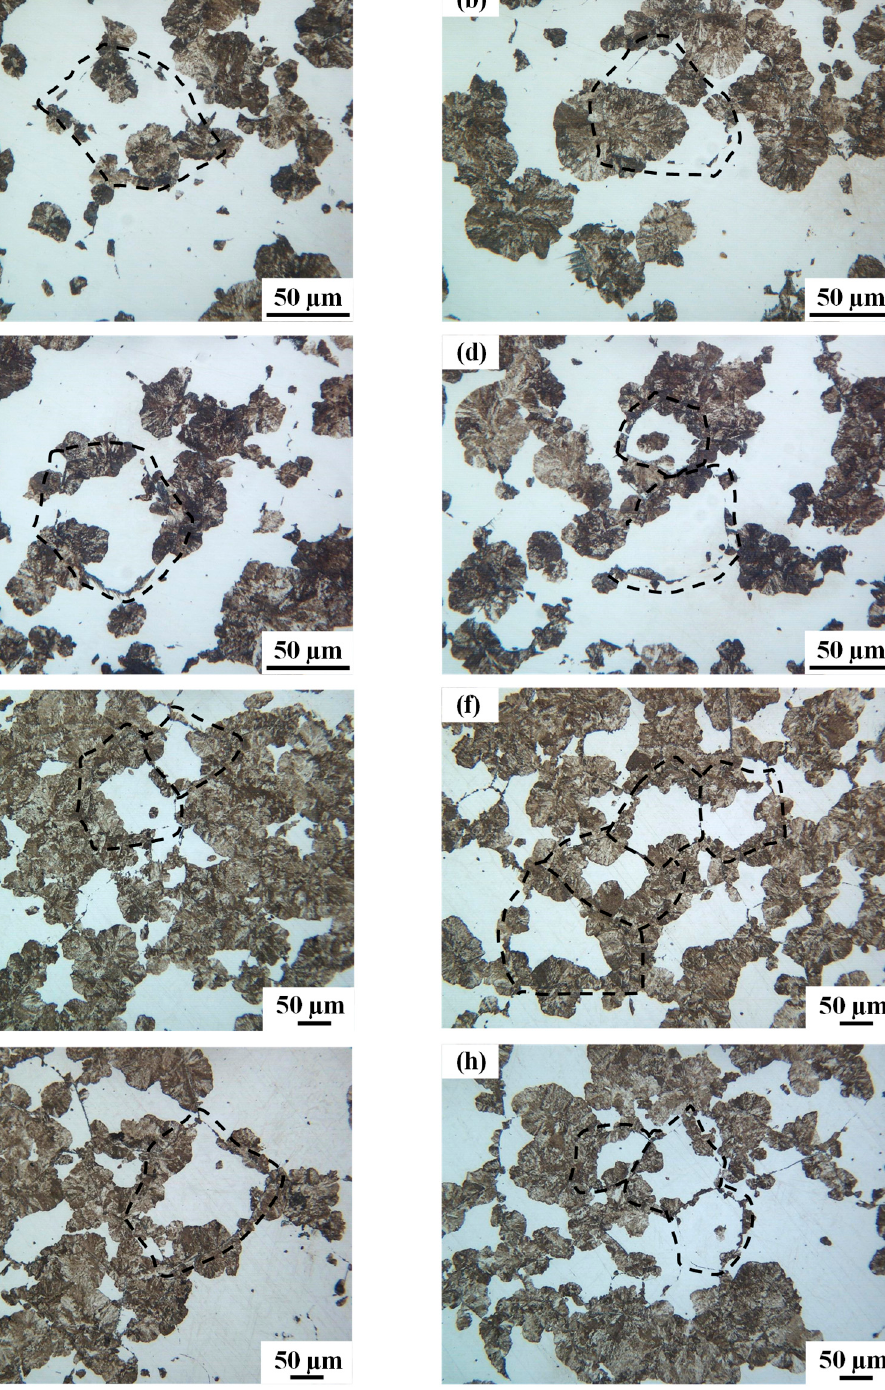
Figure 10. ( a–d ) Optical micrographs of 550 °C for 10 s after austenitizing at 880 °C; ( e–h ) Optical micrographs of 550 °C for 15 s after austenitizing at 1200 °C. Black dotted line indicates an austenite grain.